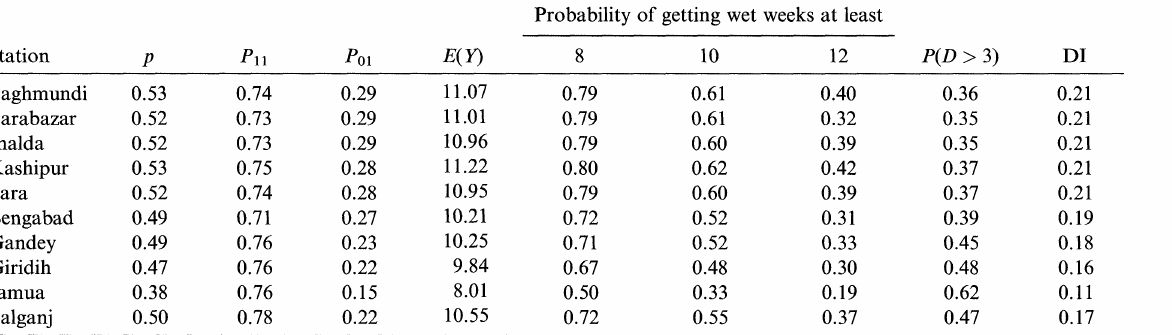
Probability of getting wet weeks at least